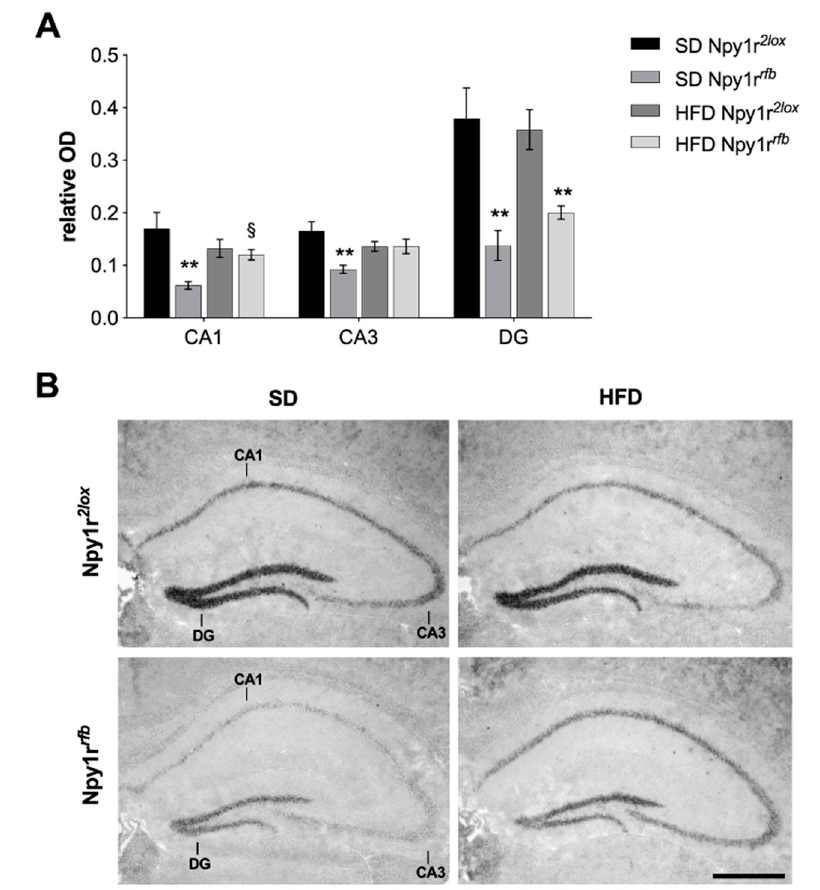
Figure 6. Npy1r mRNA expression in the hippocampus of Npy1r 2lox and Npy1r rfb mice fed with SD and HFD. ( A ) Npy1r mRNA expression in the hippocampus of Npy1r 2lox and Npy1r rfb mice fed with SD and HFD. ( B ) Representative pictures showing Npy1r mRNA signal intensity differences in the CA1, CA3 and DG of SD- and HFD-fed Npy1r 2lox and Npy1r rfb male mice. Scale bars: 250 μ m. CA1, cornu ammonis 1 hippocampal subregion; CA3, cornu ammonis 3 hippocampal subregion; DG, dentate gyrus. Values are presented as mean ± SEM ( A ). ** p < 0.01 versus Npy1r 2lox mice. § p < 0.05 versus Npy1r rfb mice on SD. Scale bars: 500 μ m.